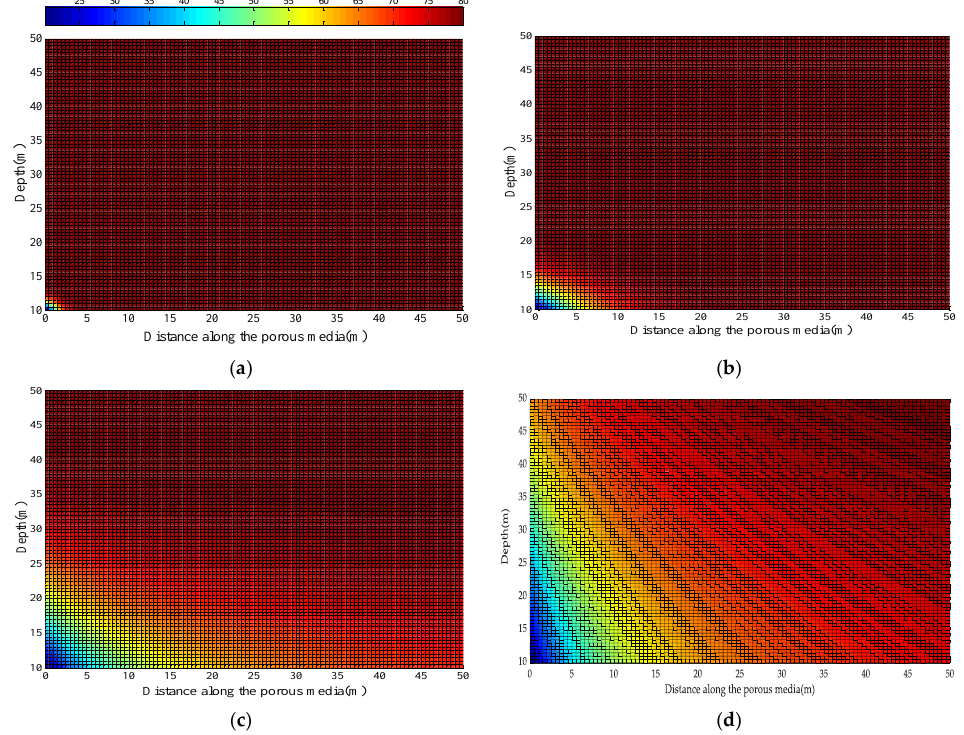
= 2.5 W/m·K at ( a ) 10 days, ( b ) 100 1